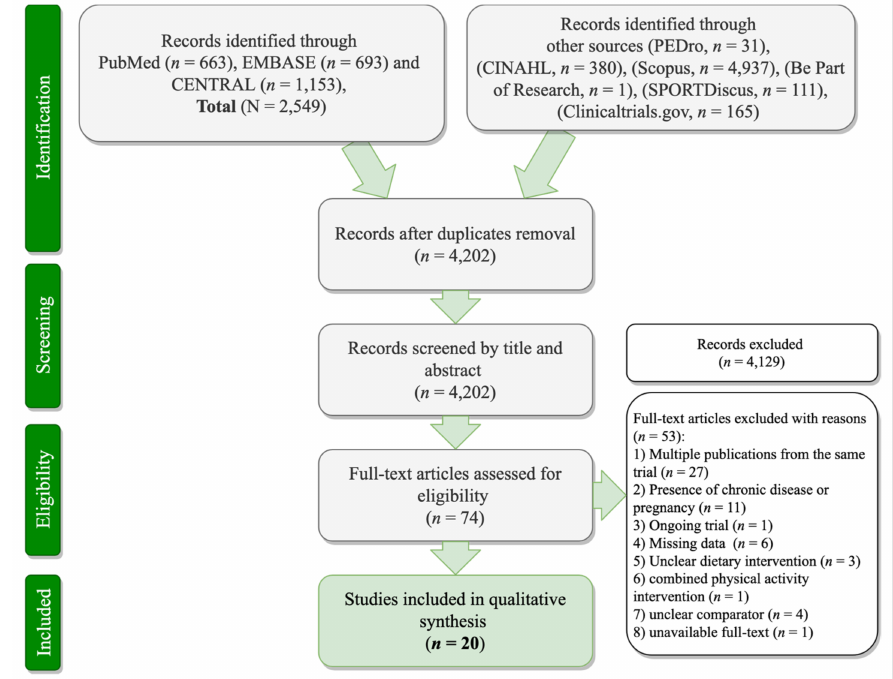
Figure 2. PRISMA flowchart of the study selection